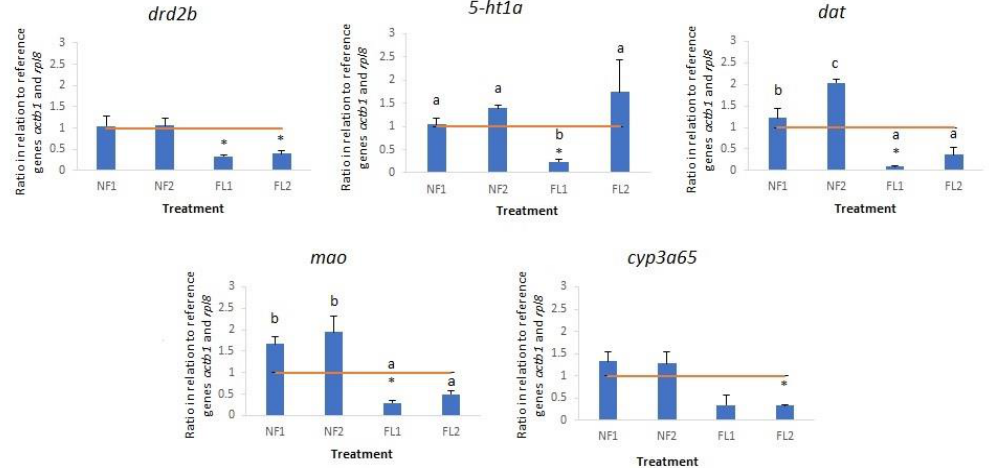
Figure 4. Relative expression of genes from cluster e. The small letters indicate the homogeneous subsets indicated by the Tukey HSD for the comparison of norfluoxetine based on MANOVA on for fold change (NF1 and NF2) and fluoxetine treatments (FL1 and FL2) ( p < 0.05). The stars indicate statistically significant differences ( p < 0.05) relative to the solvent control (from the results of the ANOVA on normalised expression, Table S2, Supplementary material). The horizontal line (x = 1) indicates the baseline expression for the solvent control.